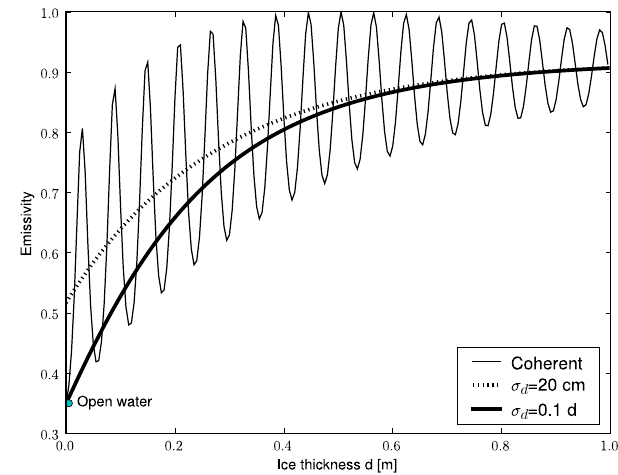
Fig. 1. Nadir 1.4GHz emissivity of a slab of Baltic sea-ice ( S = 0 . 65, T = − 2 ◦ C). The coherent and two incoherent solutions are shown for two different parameterizations of the thickness rough- ness σ d . The open water emissivity is indicated with the filled cir-